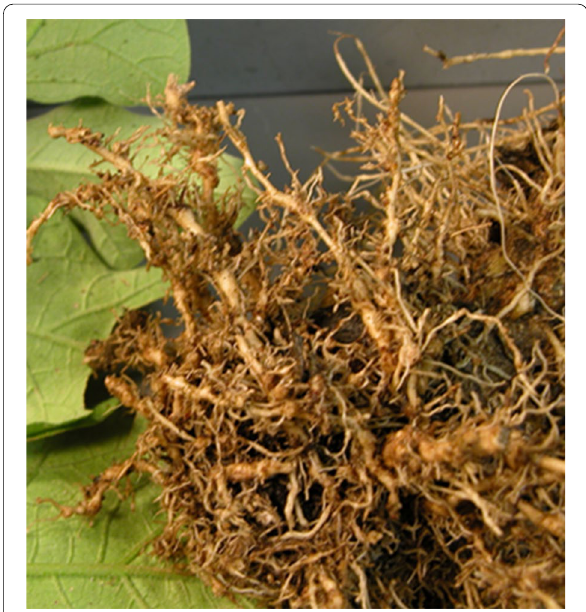
Fig. 2 Root‑knot nematodes ( Meloidogyne spp.) inducing different gall sizes of eggplant